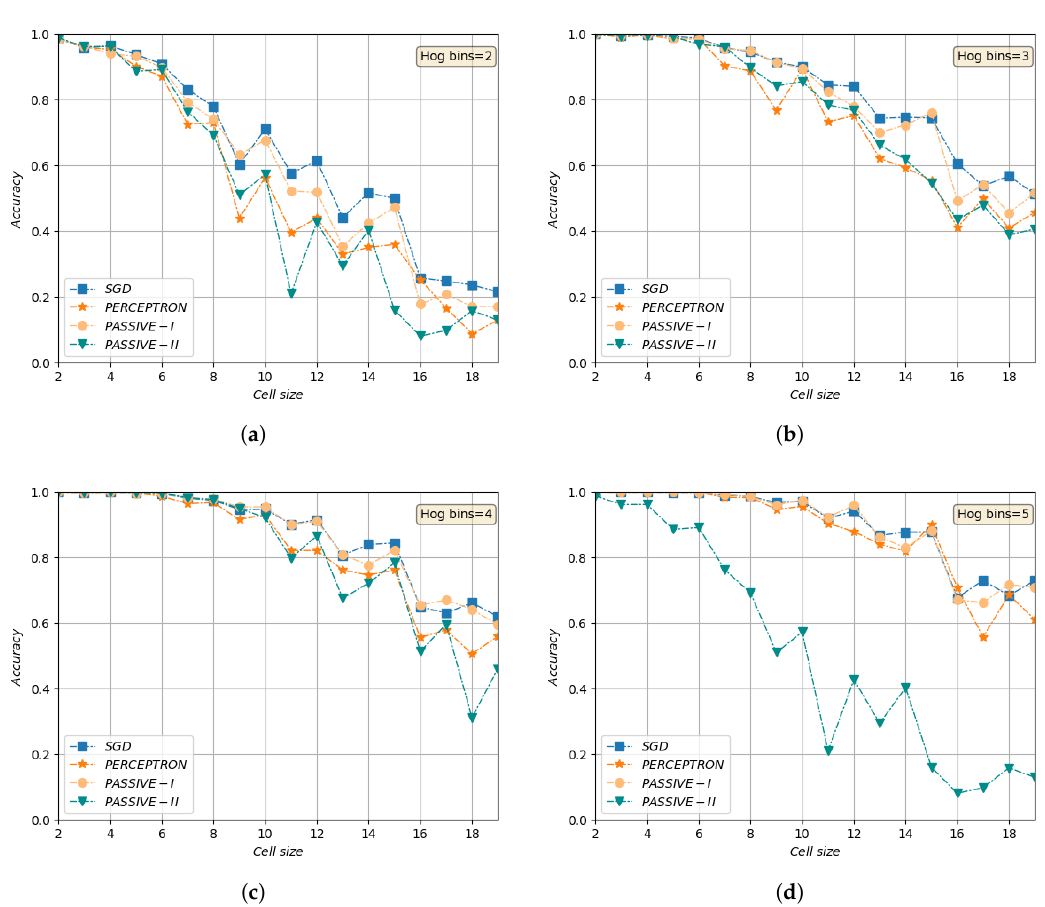
Figure 10. Object recognition accuracy of different classifiers vs. different HOG cell size, range [2,20], for ( a ) 2 bins histofram, ( b ) 3 bins histogram, ( c ) 4 bins histogram ( d ) 5 bins